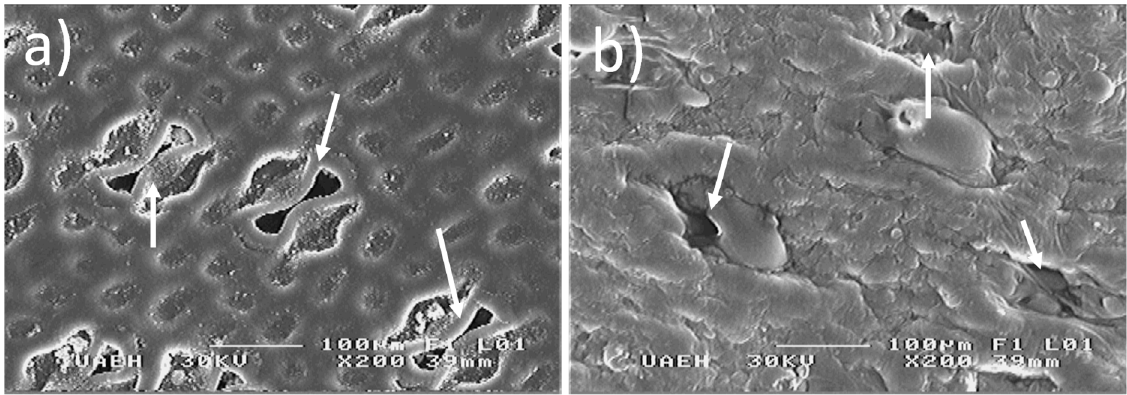
Figure 4. ( a ) SEM image of the bio-membrane without activation; ( b ) SEM image of the bio-membrane with thermal activation.